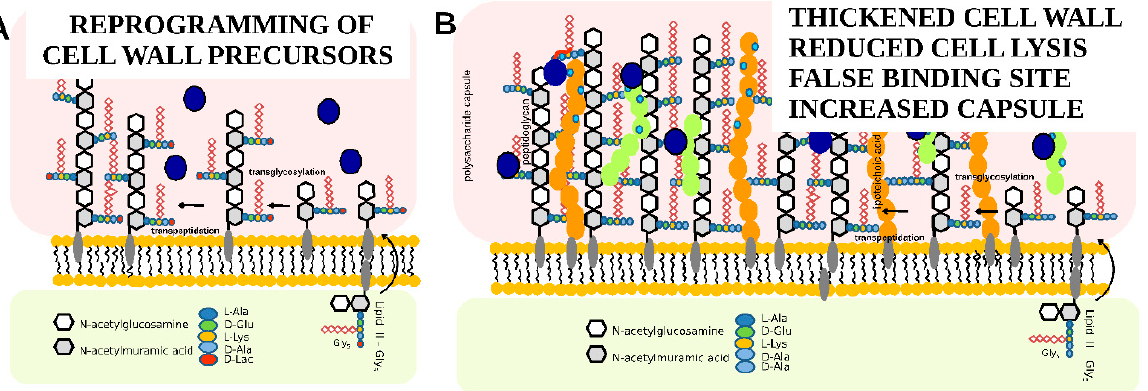
Figure 4. Schematic representation of teicoplanin resistance mechanisms: ( A )—reprogramming of cell wall precursors, ( B )—change in the properties of the cell wall.